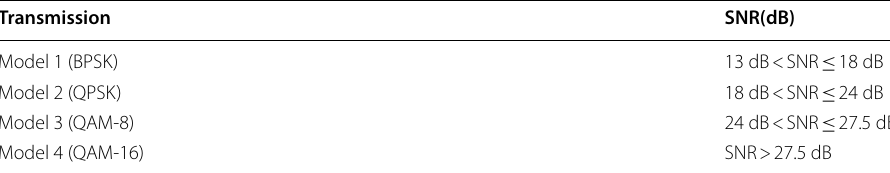
Table 2. When the SNR is quite low (SNR 13 dB), the lowest-order modulation ≤ mode BPSK cannot meet the BER of 0.01; therefore, it chooses not to transmit. When the SNR is not so low (13 dB < SNR 18 dB), the system selects QPSK as the modula- ≤ tion scheme, and the bit rate is twice that of the BPSK system. When the SNR is not so high (18 dB < SNR 27.5 dB, the system selects 8-QAM as the modulation scheme, ≤ and the bit rate is twice higher than that of the BPSK system. When the SNR is high (SNR > 27.5 dB), the system selects 16-QAM as the modulation scheme, the data rate is four times higher than BPSK, and the BER performance remains < 0.01.